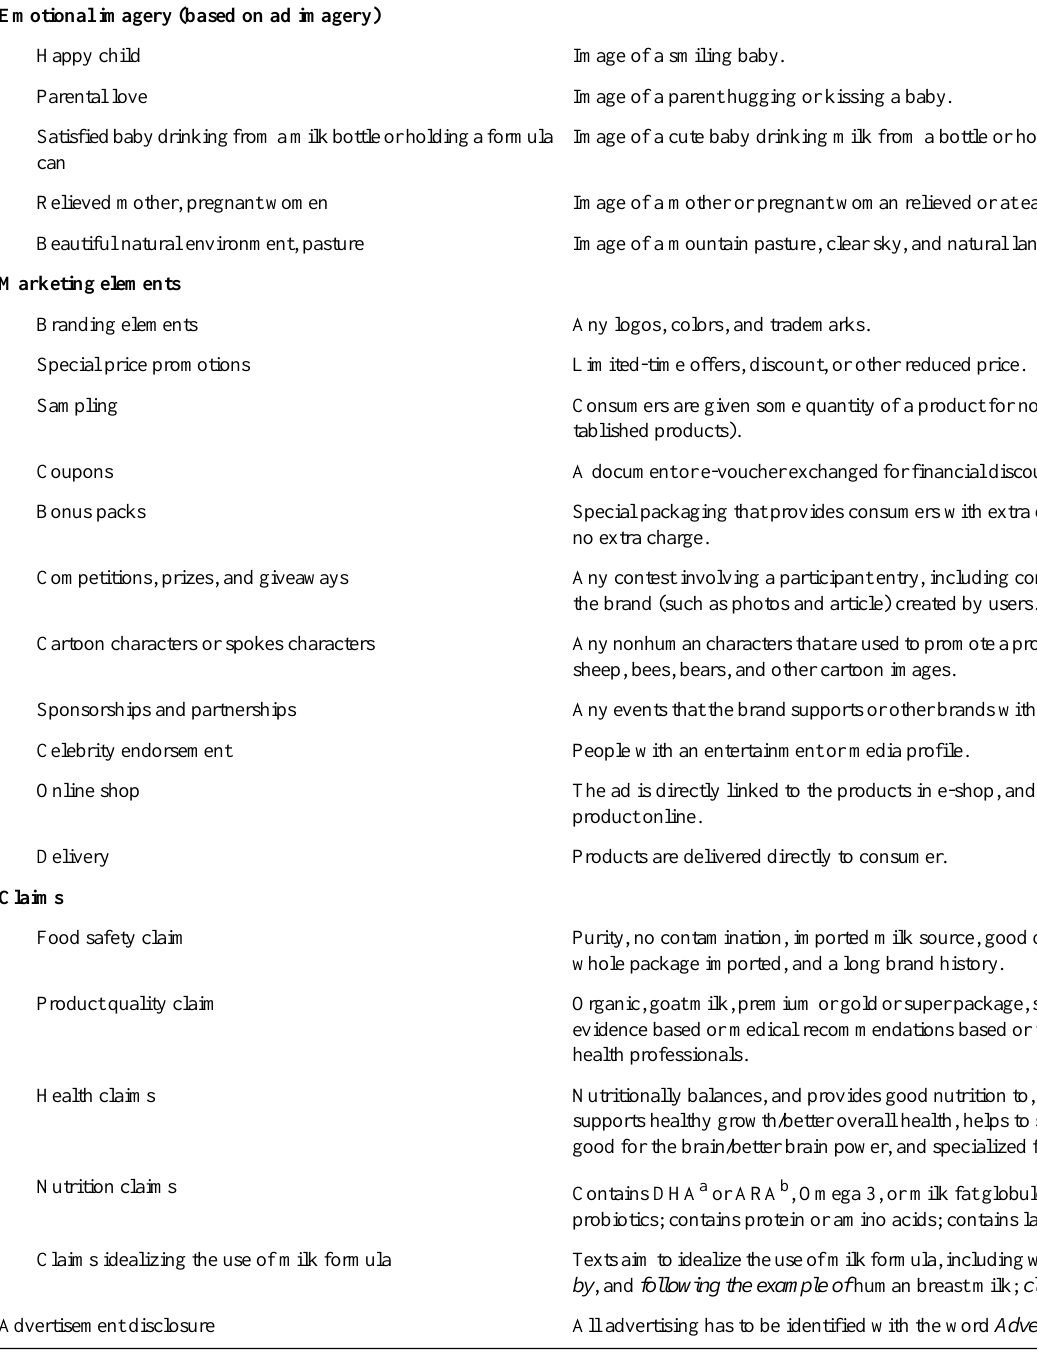
Table 1. Coding categories and options of milk formula ad content. Emotional imagery (based on ad